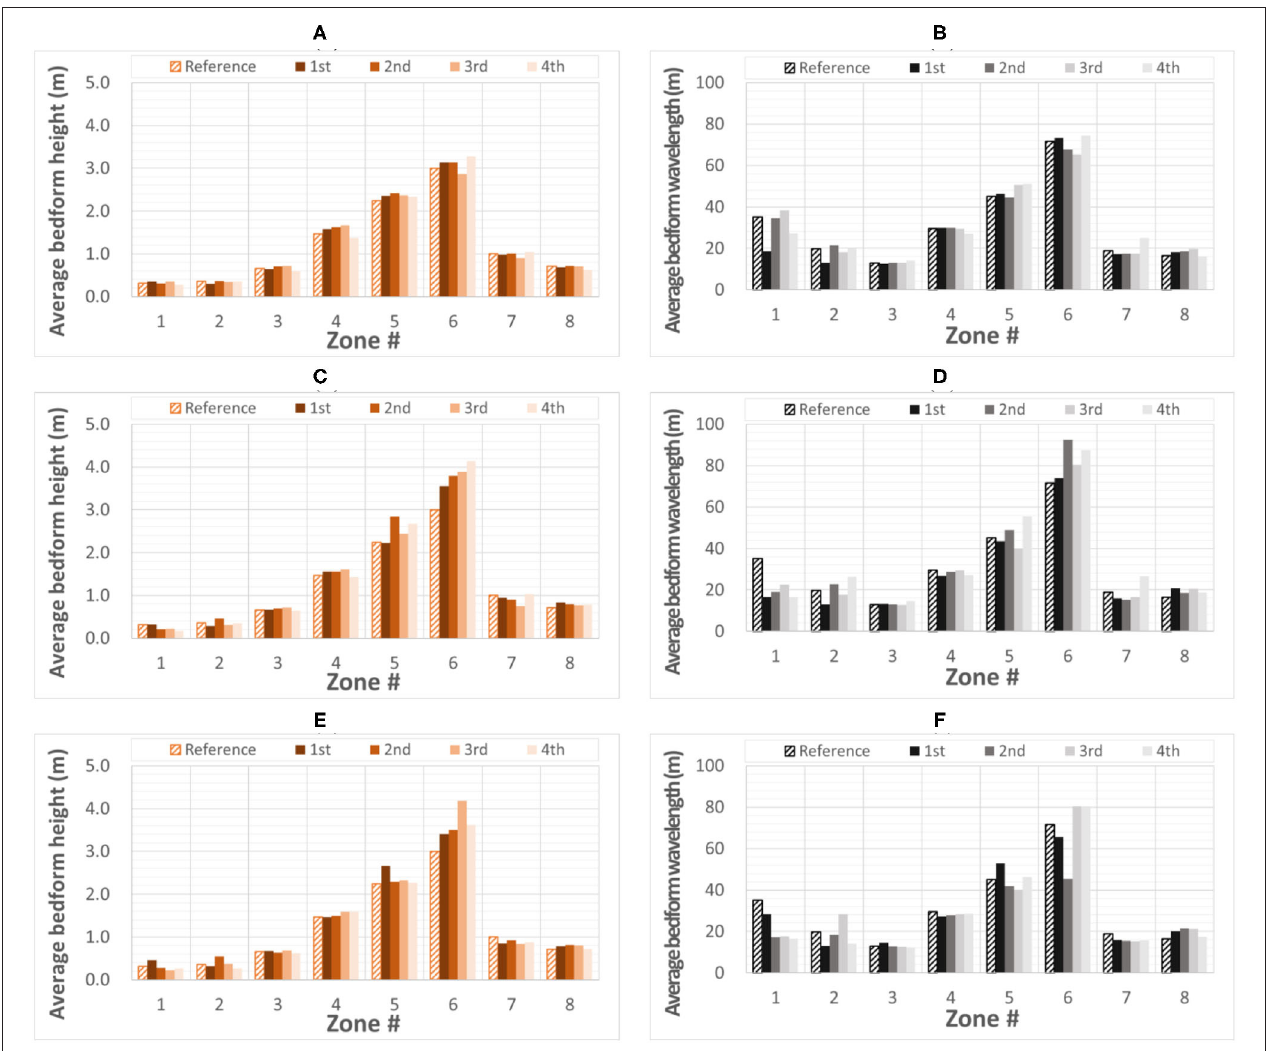
FIGURE 6 | Sensitivity of the bedform characteristics to the combined effect of a number of processed acoustic maps and length of the survey line: (A,B) average bedform height and wavelength for 1, 2, and 3 processed acoustic maps and 75% of the full length of the benchmark surveyed area, respectively; (C,D) average bedform height and wavelength for 1, 2, and 3 processed acoustic maps and 50% of the full length of the benchmark surveyed area, respectively; (E,F) average bedform height and wavelength for 1, 2, and 3 processed acoustic maps and 25% of the full length of the benchmark surveyed area,